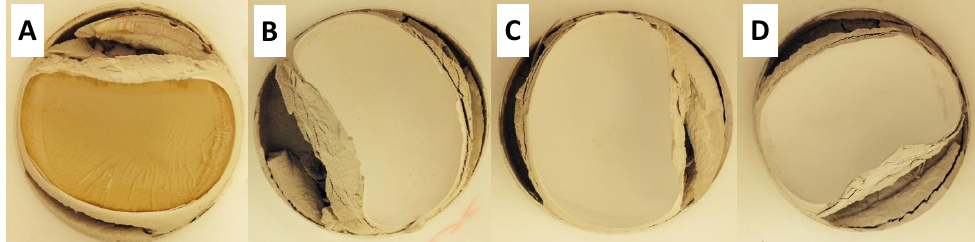
Figure 10. Dried residues from reactors A to D (from left to right) from the pyrite oxidation experiment. Table 4. Masses of dry feed ores and recovered residues from the pyrite oxidation experiment and percent change in solid mass during the experiment.